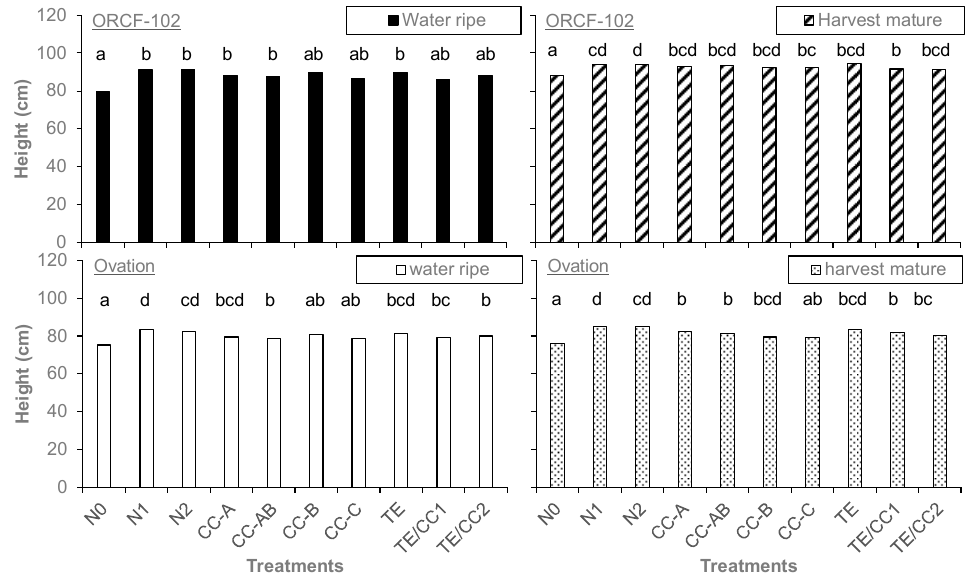
Figure 1. Plant height (cm) at water ripe (GS71) and harvest mature (GS95) for the two soft white winter wheat (SWWW) varieties among PGR-N treatment combinations across two years in Adkins fine sandy loam soil in Oregon. N0 = no fertilization; N1 = normal N rate; N2 = high-N rate without PGR application; CC-A = applying CC at GS30-32; CC-AB = applying CC at GS30-32 and GS37-39; CC-B = applying CC at GS37-39; CC-C = applying CC at GS21-26; TE = applying TE at GS30-32; TE/CC1 = applying TE at GS30-32 and applying CC (0.442 L ha − 1 a.i.) at GS37-39; TE/CC2 = applying TE at GS30-32 and applying CC (1.004 L ha − 1 a.i.) at GS37-39. Different letters on the top of each column indicate significant differences among treatments at 5% level according to LSD test.